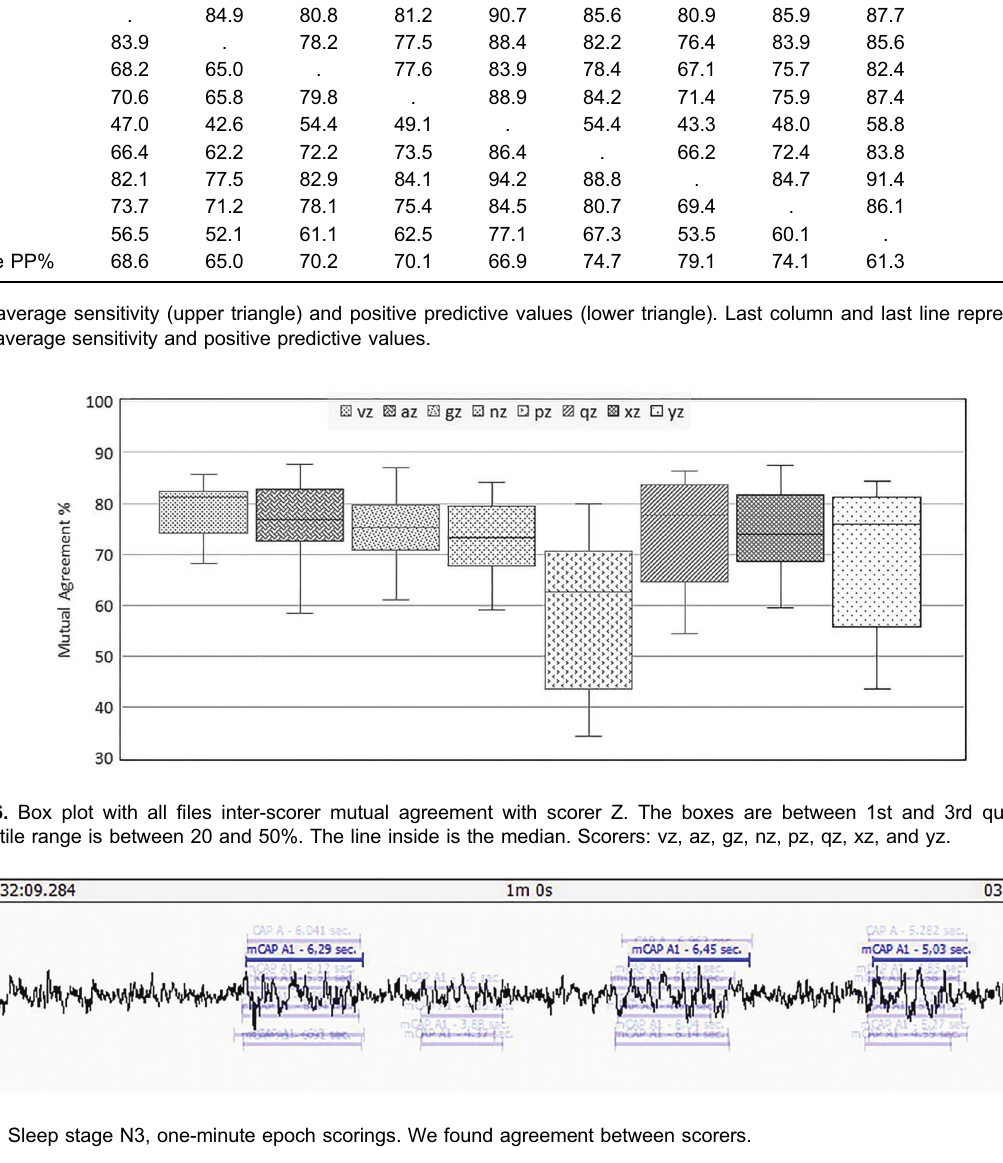
Table 3. Inter-scorers average sensitivity (SS%) and positive predictive values (PP%). SS% PP% v a g N